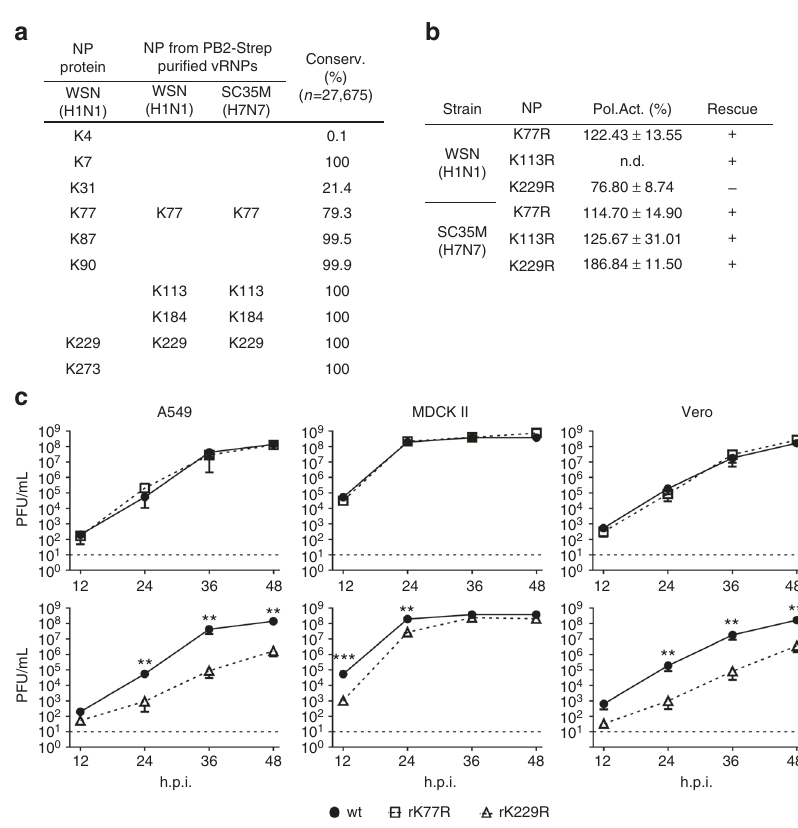
Fig. 1 Identi fi cation of acetylated NP lysine residues and their role in polymerase activity after substitution with arginine. a NP acetylation sites detected by mass spectrometry using transiently expressed NP in HEK293T cells or puri fi ed vRNPs from infected A549 cells. Degree of lysine conservation is indicated. b Polymerase reconstitution assay in HEK293T cells in the presence of the indicated NP mutants. Polymerase activity is shown as mean and s.d. of at least three independent experiments (n.d., not determined). Plus indicates successful rescue of recombinant viruses encoding acetylation-de fi cient NP. c MDCK II, A549 and Vero cells were infected with the indicated viruses at an MOI of 0.001 and viral growth was monitored 12, 24, 36 and 48 h.p.i. by plaque assay. Dashed lines represent the detection limit. ** p < 0.01; *** p < 0.001. Error bars indicate the mean and s.e.m. of at least three independent experiments. Student ’ s t -test was used for two-group